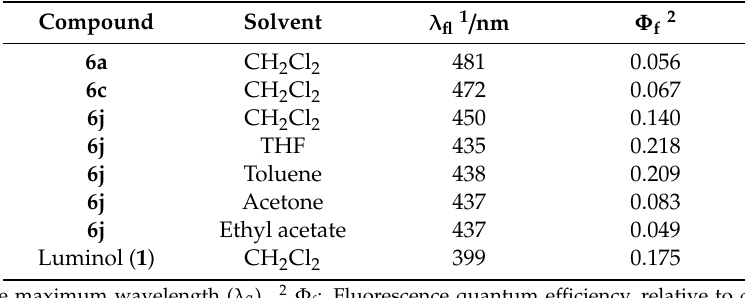
Table 3. Quantum yields of fluorescence of luminol ( 1 ) and pyrazolopyridopyridazine diones 6a , 6c , and 6j .